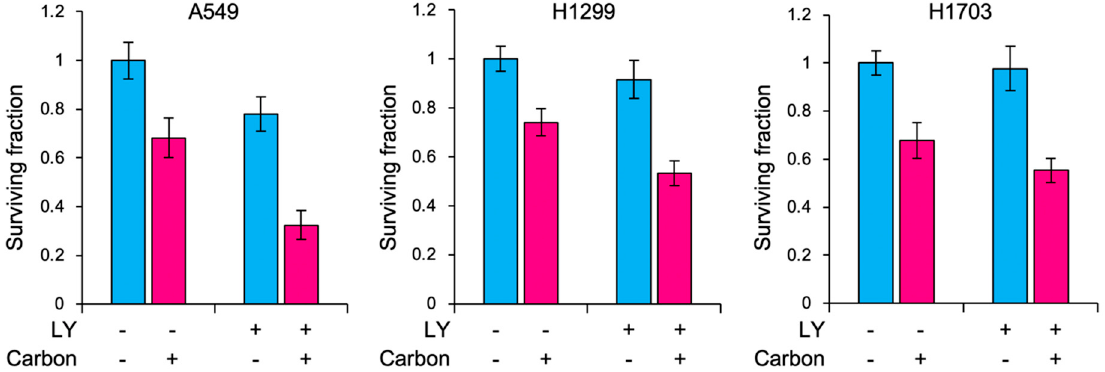
Figure 4. Sensitizing e ff ect of LY2874455 on carbon ions as assessed by clonogenic assays. Cells were exposed to LY2874455 (LY, 40 nM) for 1 h and irradiated with carbon ions for 3 Gy (RBE).